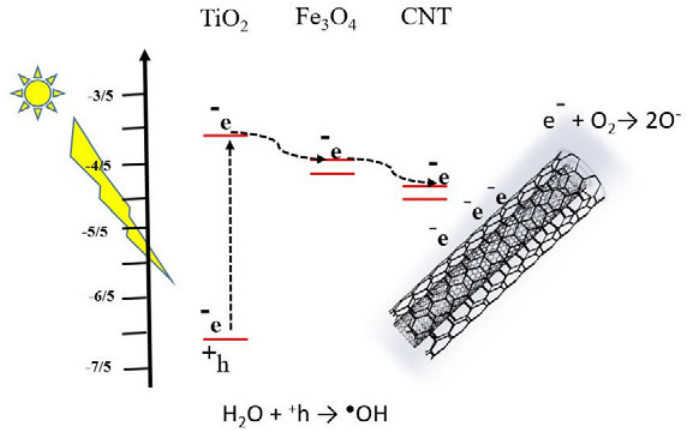
Fig. 1. Mechanism of Photocatalytic Performance Improvement in TiO